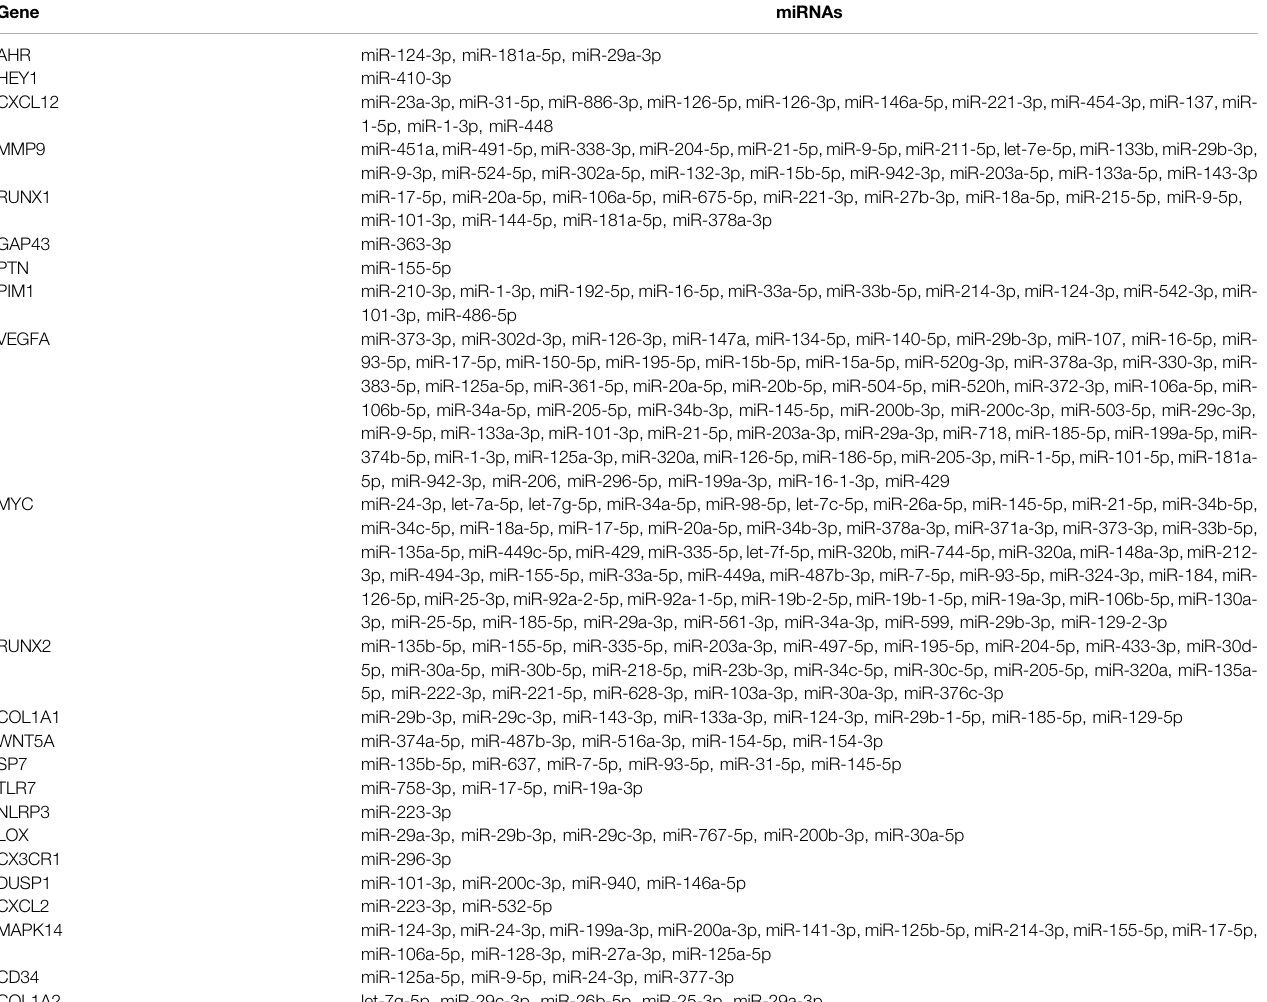
TABLE 5 | List of miRNAs targeting at knee OA-related key